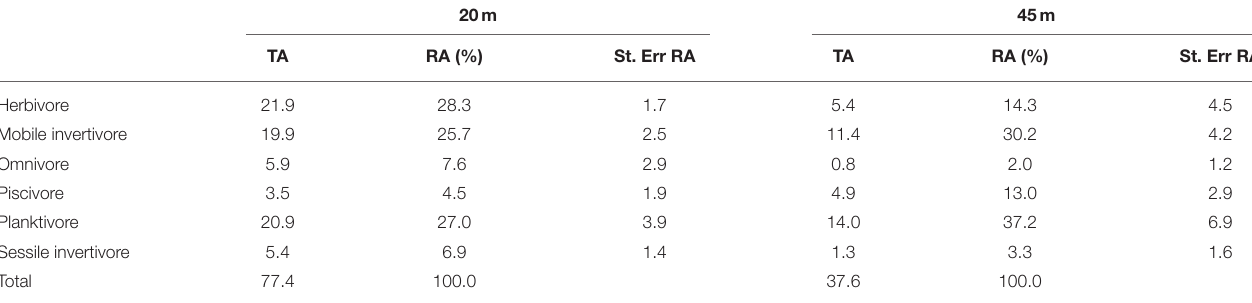
TABLE 3 | Total and relative abundances of fish feeding guilds at 20 and 45m depth fish